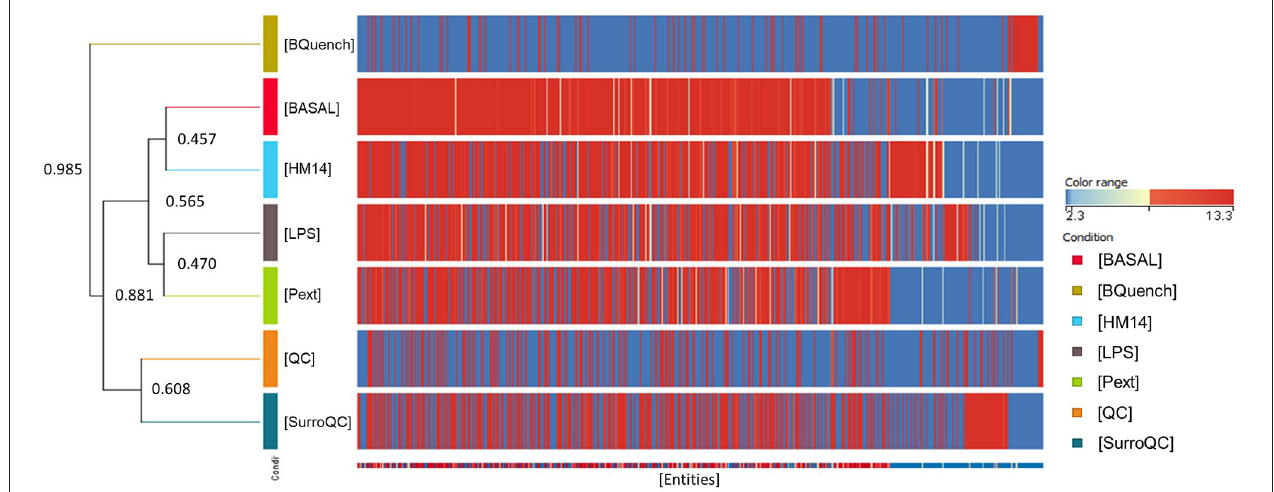
FIGURE 5 | Comparison of seven groups of samples using normalized intensities of annotated metabolites. The dendogram was produced by applying a hierarchical clustering